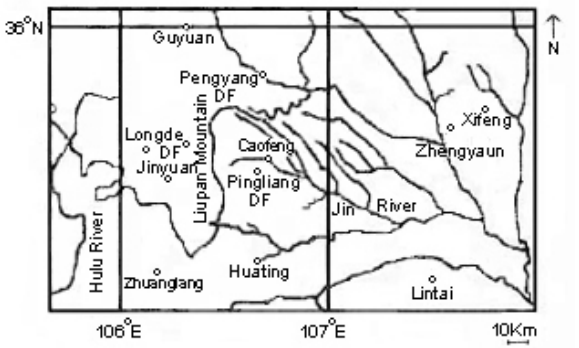
Fig. 2. The spatial distribution of lightning frequency in units of CG flashes per square kilometer from June to August in 1997 in the observation